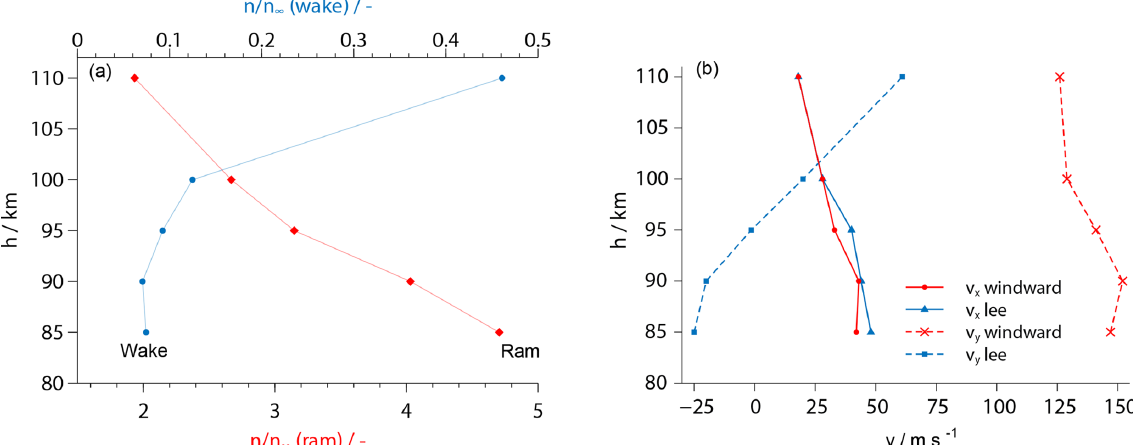
Figure 8. (a) Aerodynamic correction factors for sensors in ram and wake position derived from numerical simulations at the windward side. Each dot represents a calculated trajectory point. (b) Longitudinal ( x ) and lateral ( y ) velocity components at the sensor position, calculated in ram.